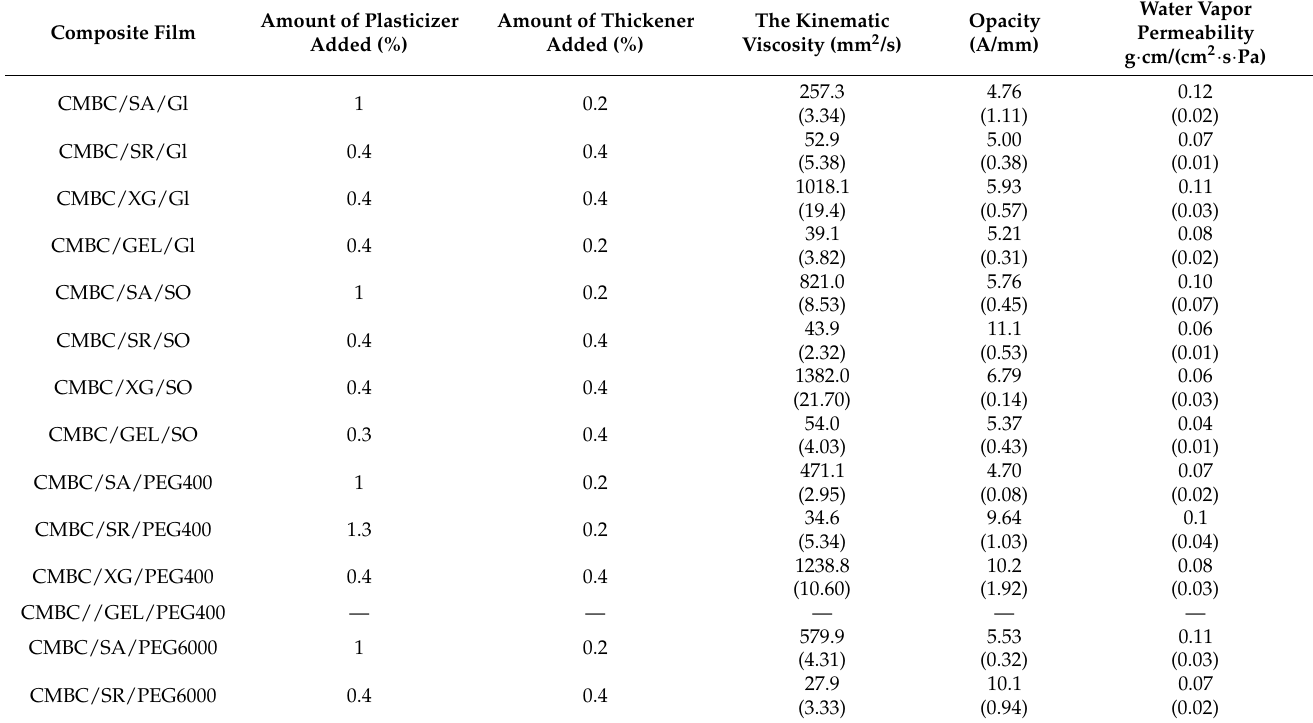
Table 6. The physical properties of CMBC composite films with difference